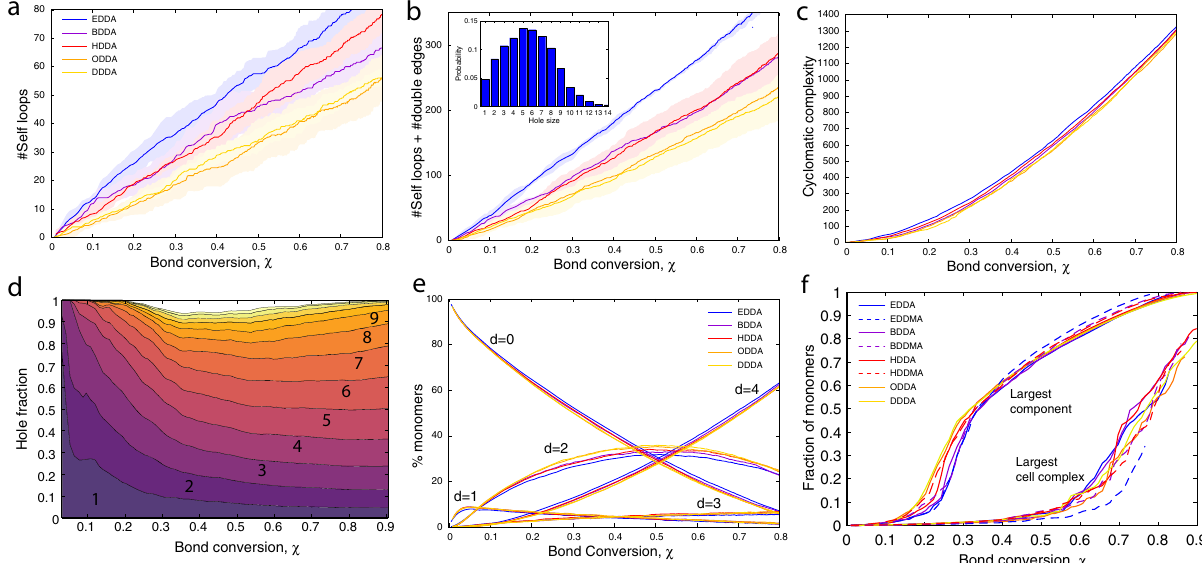
Fig. 4 Graph-theoretical and topological properties of the polymer network. a Number of nodes with one self-loop. b Number of nodes with either a double edge or a self loop; the inset shows an averaged distribution of hole sizes at χ = 0.8. c Universal collapse of the overall cyclomatic complexity. d The fraction of holes of indicated size as a function of bond conversion. Supplementary Fig. 12 reports hole statistics for each monomer separately. e Degree distributions as a function of conversion feature universality. f Universal collapse of the sizes of the largest component and cell complex in different systems. The largest connected components traverses percolation transitions between χ = 0.15 and χ = 0.25 depending on the monomer type. The sizes of the largest connected cell complex feature a second percolation transition around χ = 0.7. Supplementary Fig. 11 reports the con fi dence